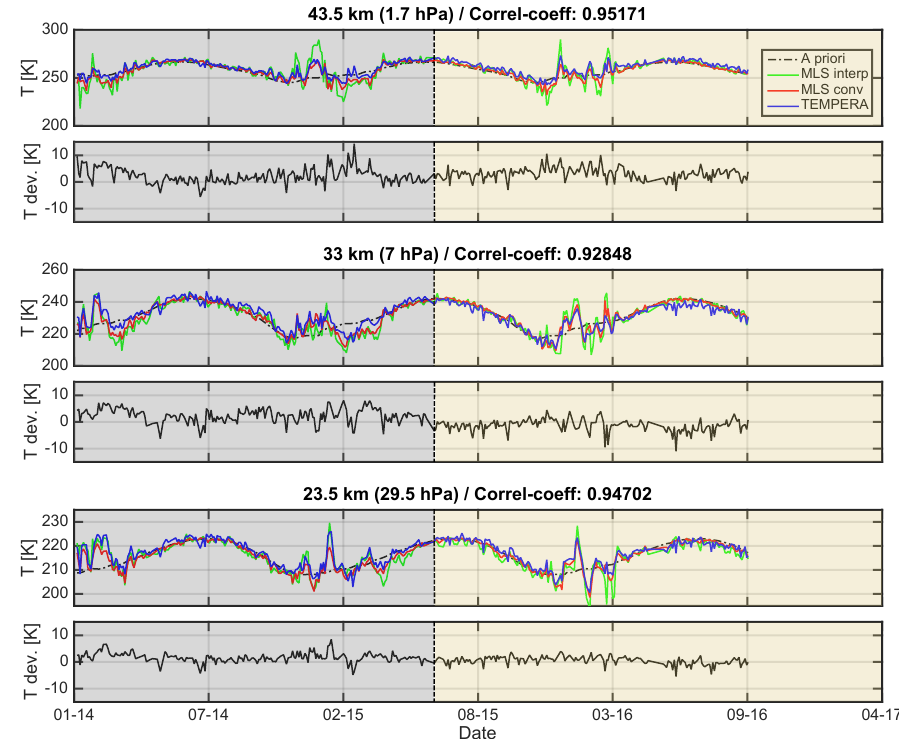
Figure 9. Stratospheric temperature evolution and temperature deviations at different altitudes for TEMPERA and MLS. Different back- ground colours are used to distinguish between period 1 and 2 (grey and light brown,